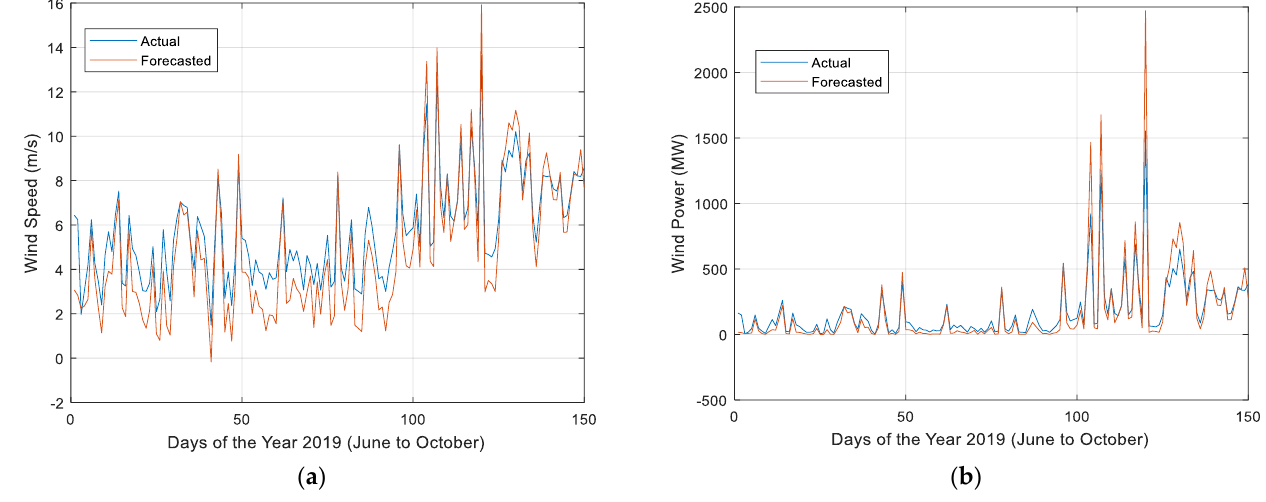
Figure 16. ( a ) Comparative analysis of wind speed forecasting by the CFNN trained through PSO. ( b ) Comparative analysis of wind power forecasting by the CFNN trained through PSO.